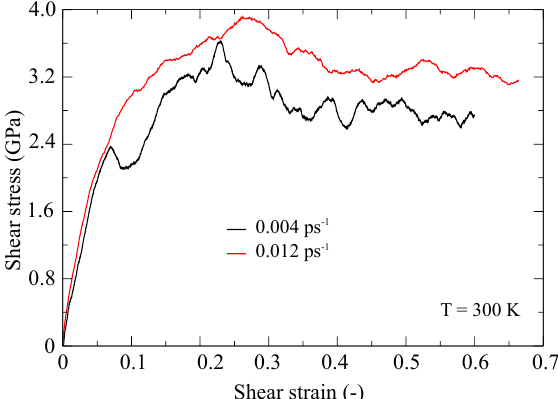
Figure 8. Shear stress-strain curves at different strain rate